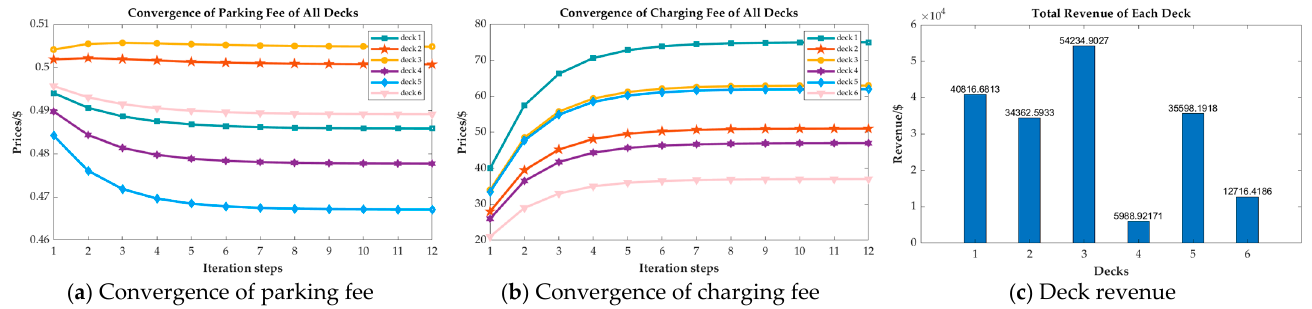
Figure 8. The electricity price, parking fee, and total revenue after halving the number of SC cus-